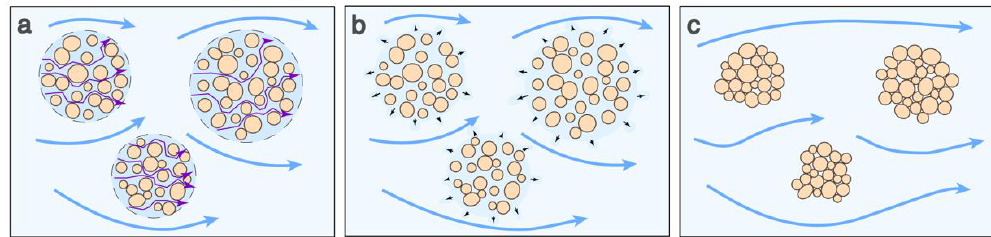
Figure 1. Schematic diagram demonstrating the shear-induced densification phenomenon experienced by a model aggregate. The blue arrows represent inter-aggregate fluid flow while the smaller purple arrows represent intra-aggregate fluid flow following more tortuous flow paths through the permeable aggregates ( a ). The resulting fluid pressure gradient leads to the expulsion of the internal pore water ( b ) and collapse and densification of the aggregates ( c ).